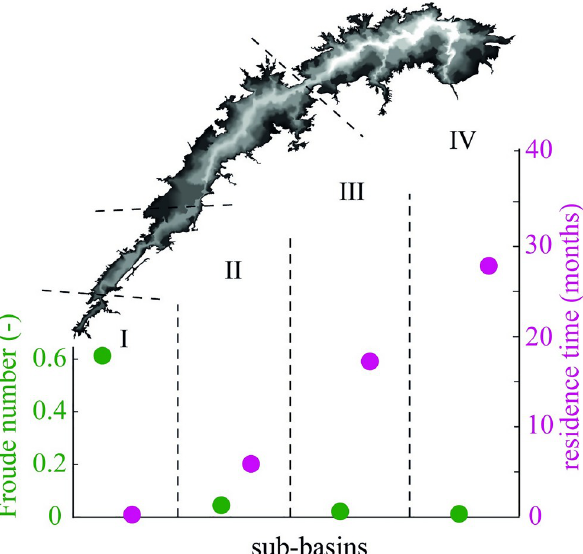
Fig 4. Froude number and water residence time. Froude number and water residence time calculated for each sub- basin of Lake Kariba. The Froude number decreases from the first toward the fourth sub-basin, and the water residence time increases toward the fourth